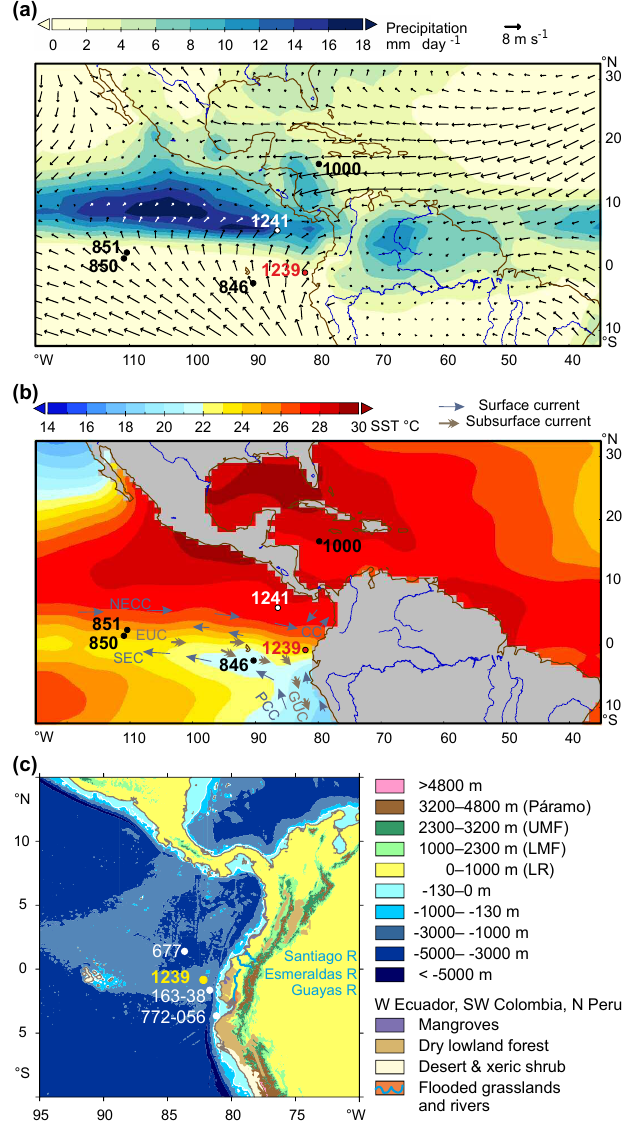
Figure 2. Modern climate (boreal summer) and vegetation and core site positions of ODP sites 677, 846, 850, 851, 1000, 1239, and 1241; Trident core TR163-38; and M772-056 mentioned in the text. (a) 1981–2010CE long-term monthly July precipitation in millimeters per day (CPC Merged Analysis of Precipitation, https://www.esrl.noaa.gov/psd/data/gridded/data.ncep.reanalysis.derived.html, last access: February 2008) and 0.995 σ level (near-surface) wind field (NCEP). July is the middle of the rainy season in northern South America, when the ITCZ is at its northern boreal summer position. Salinity estimates for the Caribbean indicate a position of the ITCZ further north during the Pliocene. Direction of wind is not favorable for wind transport of pollen and spores to ODP Site 1239. (b) Long-term monthly July sea-surface temperatures (NODC), and surface and subsurface currents of the eastern equatorial Pacific (Mix et al., 2003). NECC, North Equatorial Countercurrent; SEC, South Equatorial Current; PCC, Peru–Chile Current (continuation of the Humboldt Current); CC, Coastal Current; EUC, Equatorial Undercurrent; GUC, Gunther Undercurrent. (c) Contours, bathymetry (ETOPO1), main rivers in Ecuador, and vegetation. Transport of pollen and spores in the ocean over the Peru–Chile Trench, which is very narrow east of the Carnegie Ridge, probably takes place in nepheloid layers. Páramo vegetation is found between 3200 and 4800m; upper montane Andean forest (UMF) grows between 1000 and 2300m, sub-Andean lower montane forest (LMF) between 1000 and 2300m, and lowland forest (LR) below 1000m. The distribution of desert and xeric shrubs in northern Peru and drier broad-leaved forest, flooded grasslands, and mangroves in Ecuador and Colombia is denoted in different colors (see legend, WWF). Source areas of pollen and spores in sediments of ODP Site 1239 are sought in western Ecuador, northwestern Peru, and southwestern Colombia (see text). Abbreviated Web sources and retrieval dates are listed in the reference